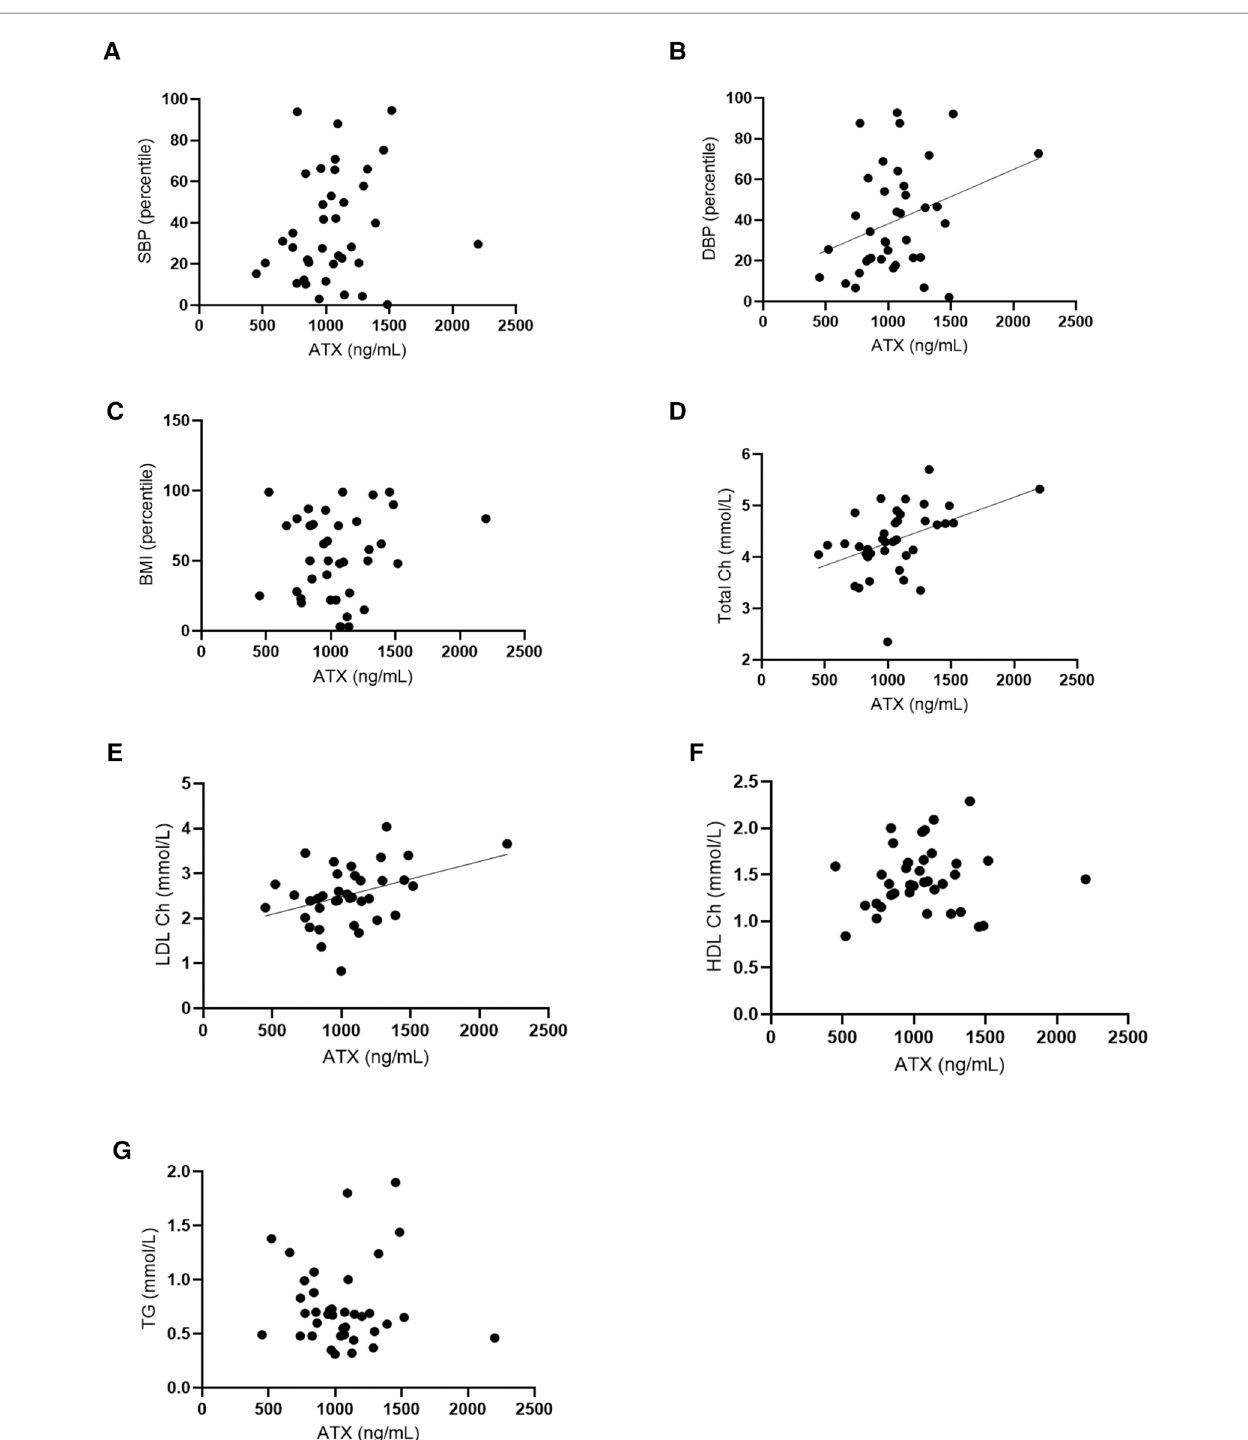
FIGURE 2 Autotaxin and age are positively correlated with cardiovascular risk and fat metabolism markers. ( A ) Correlation tests were conducted between ATX circulating levels (ng/ml) and systolic blood pressure (SBP, percentile). Spearman correlation test: r =0.34, IC95%=0.01 – 0.61, p =0.04. ( B ) Correlation tests were performed between ATX circulating levels (ng/ml) and diastolic blood pressure (DBP, percentile). Spearman correlation test: r =0.34, IC95%=0.01 – 0.61, p =0.04. ( C ) Correlation tests were done between ATX circulating levels (ng/ml) and body mass index (percentile). Spearman correlation test: non- signi fi cant. ( D ) Correlation tests were carried out between ATX circulating levels (ng/ml) and total cholesterol (Total Ch) (mmol/L). Spearman correlation test: r =0.46, IC95%=0.14 – 0.68, p =0.0046**. ( E ) Correlation tests were done between ATX circulating levels (ng/ml) and LDL cholesterol (LDL Ch) (mmol/L). Spearman correlation test: r =0.33, IC95%=0.01 – 0.59, p =0.0433*. ( F ) Correlation tests were performed between ATX circulating levels (ng/ml) and HDL cholesterol (HDL Ch) (mmol/L). Spearman correlation test: non-signi fi cant. ( G ) Correlation tests were done between ATX circulating levels (ng/ ml) and triglyceride levels (TG) (mmol/L). Spearman correlation test: non-signi fi cant. Age is correlated with these for blood factors and the Spearman correlation tests: Age and SBP: non-signi fi cant. Age and DBP: r = − 0.4369, IC95%= − 0.67 – ( − )0.13, p =0.0061. Age and per BMI: r =0.0168, IC95%= − 0.31 – 0.34, p =0.9204 non-signi fi cant. Age and total Ch: r = − 0.3670, IC95%= − 0.62 – ( − )0.04, p =0.0234. Age and LDL Ch: r = − 0.2200, IC95%= − 0.61 – 0.12, p =0.1845 non-signi fi cant. Age and HDL Ch: r = − 0.3649, IC95%= − 0.62 – ( − )0.014, p =0.0243. Age and TG: r =0.2168, IC95%= − 0.12 – 0.51, p =0.1911 non-signi fi